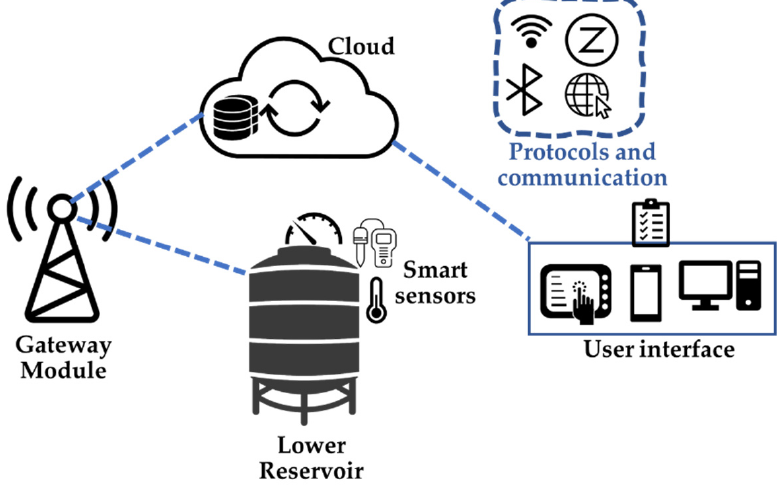
Figure 5. Simplified schematic of the IoT process for water quality monitoring.